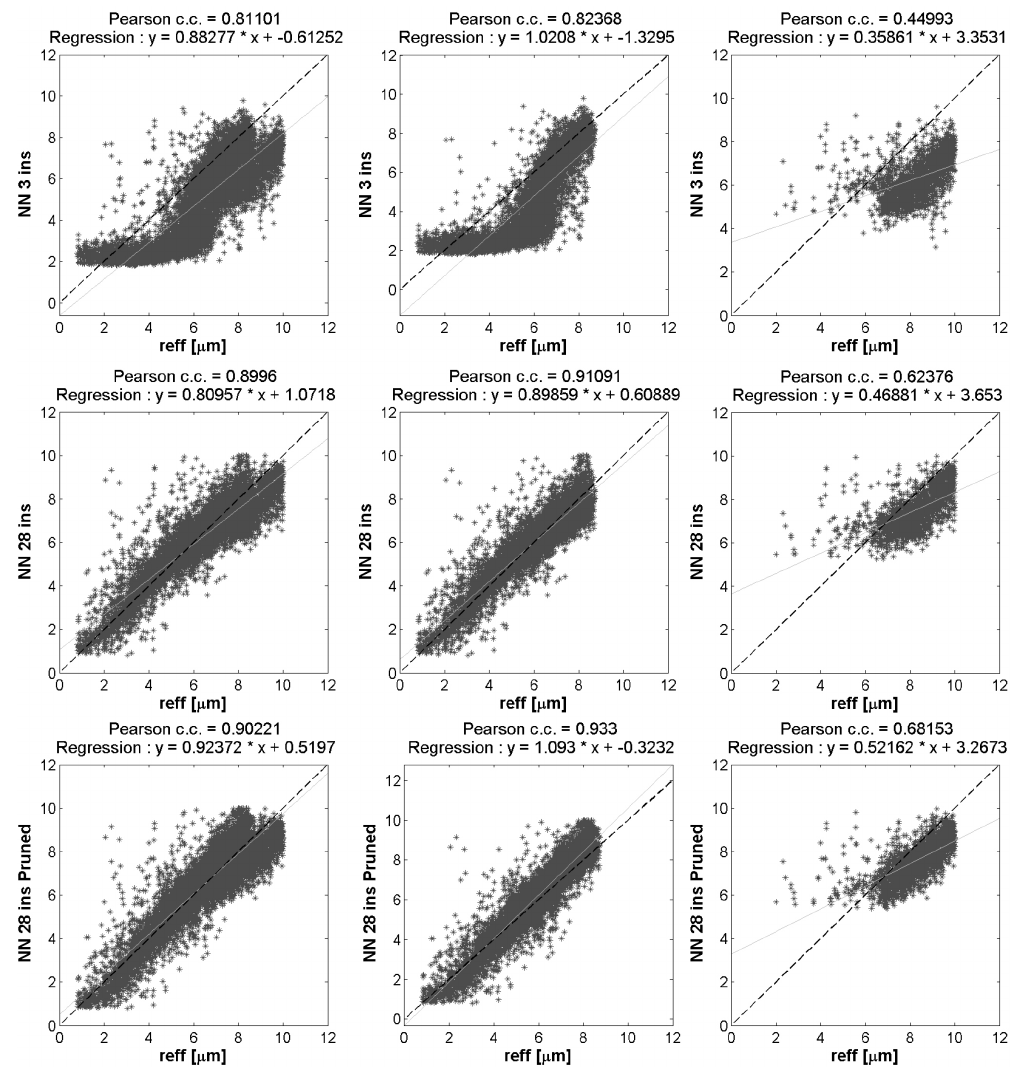
Figure 10. Scatterplots for r eff networks, 3 inputs (top row), 28 inputs (middle row) and 28 inputs pruned (bottom row), applied to the validation set of 16 May 2010, 12:30UTC, divided into total patterns (left column), patterns over sea (middle column) and patterns over meteorological clouds (right